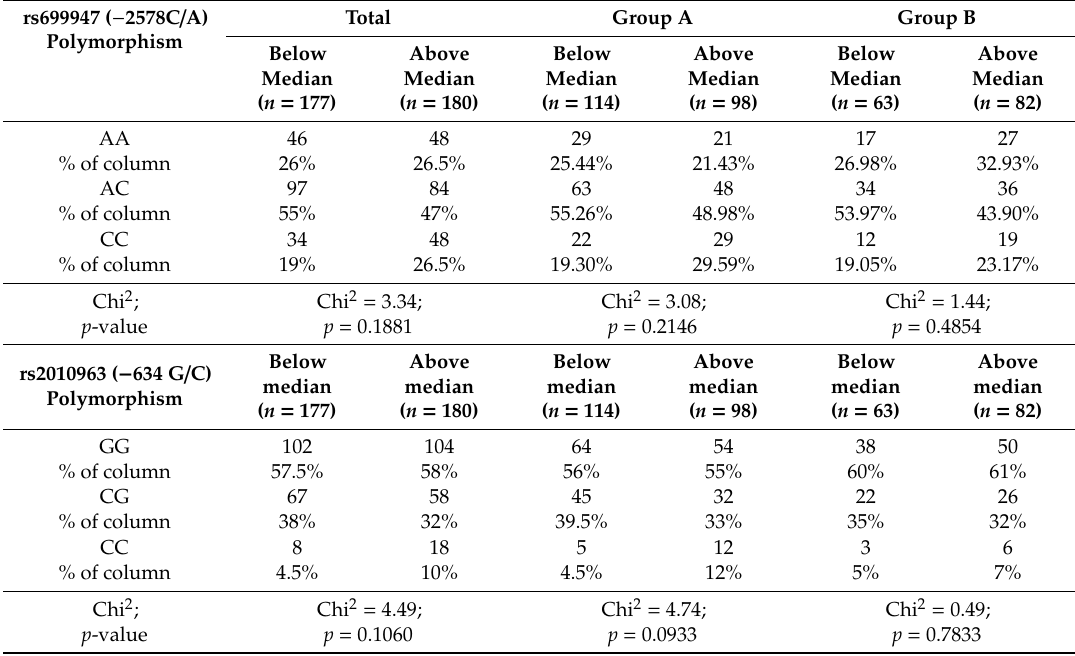
Table 6. Distribution of genotypes of rs699947 and rs2010963 variants of VEGF gene in relation to serum concentration of VEGF-A below and above the